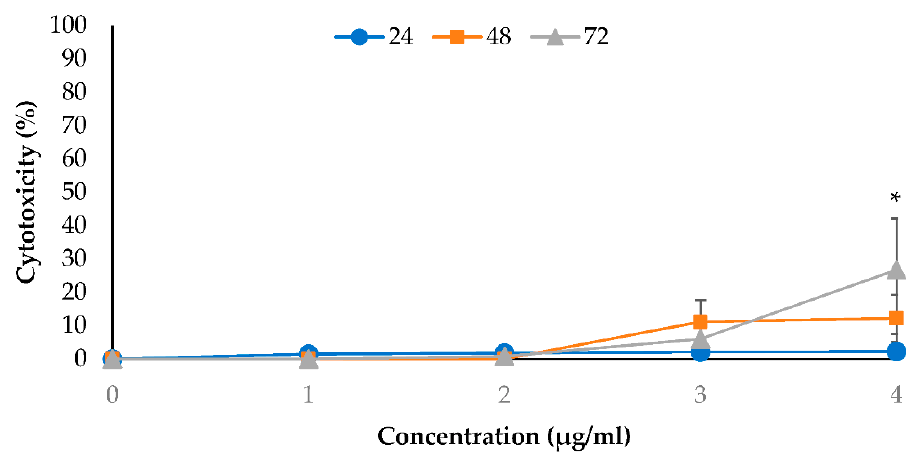
Figure 4. The cytotoxic effect of 2-DG (1–4 mM) was assessed by LDH assay. Treatments were performed for 24, 48 and 72 h and results are expressed as percentage of cytotoxicity at various concentrations. The data were shown as the mean values ± S.D. for three independent experiments, and the statistical analysis was determined using a Student’s t -test, with the * symbol showing a significant difference ( p < 0.05) in comparison to control untreated cells.